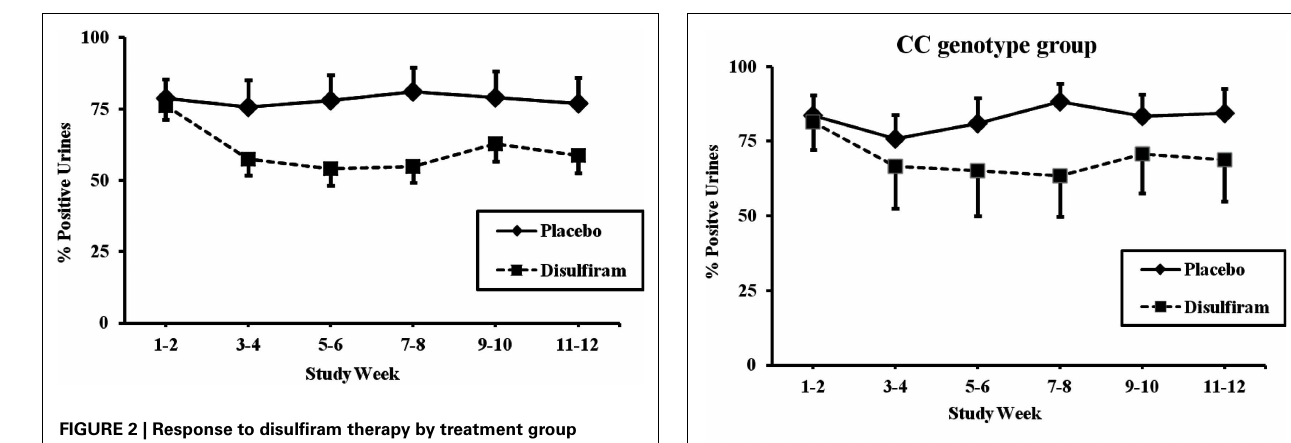
FIGURE 2 | Response to disulfiram therapy by treatment group ( N = 56). Cocaine-positive urine toxicology screens are shown for each 2week time period across the 12-week trial as percent positive urines.The placebo treatment group ( N = 32) is represented by a solid line and the disulfiram (250mg/day) treatment group ( N = 24) is represented by a dashed line. Standard error bars are shown for each time point. Only data from study participants with complete urine toxicologies were included in the analysis.